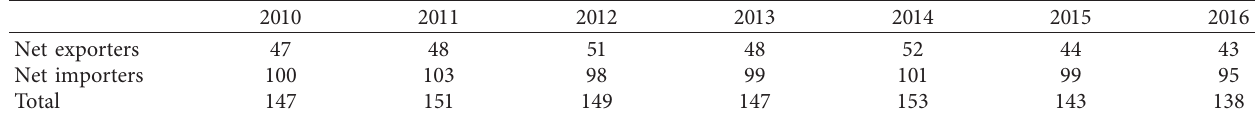
Table 1: Numbers of crude oil trading countries from 2010 to 2016.